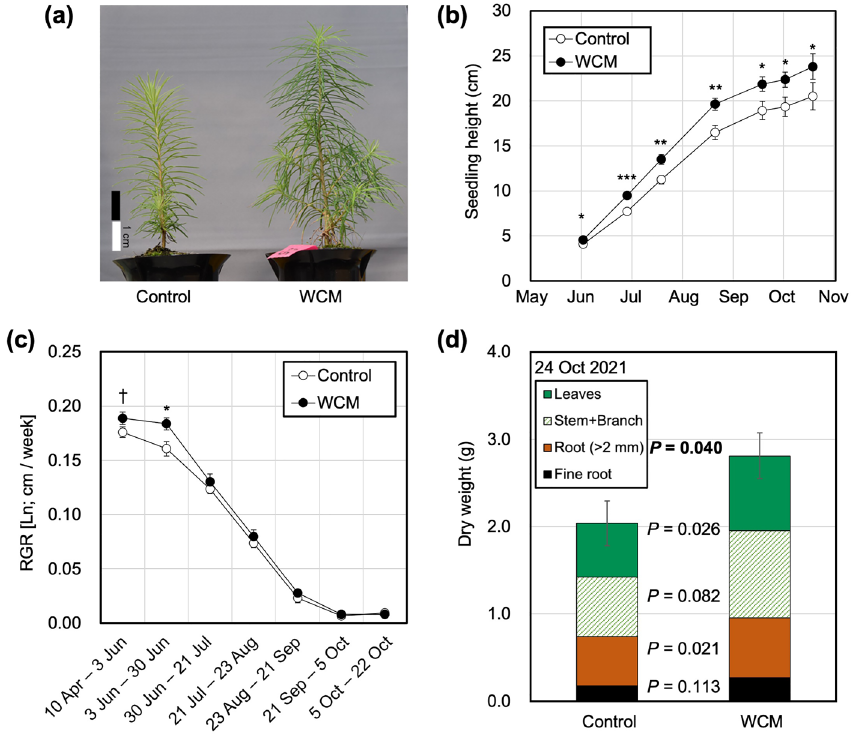
Figure 3. Growth of Japanese larch tree seedlings under UV-to-red WCM film. ( a ) Photograph of 4-month- old Japanese larch seedling grown under UV-to-red WCM film and non-treated film (control). ( b ) Seasonal change of seedling height. ( c ) Seasonal change of RGR. RGR was normalized by natural logarithm per week. Open and closed circles denote treatments of the control and WCM films, respectively. Error bars denote standard error. Statistical significance was examined in each month by Student’s t-test ( n = 81 and 70, † P < 0.1, * P < 0.05, ** P < 0.01, *** P < 0.001). ( d ) Dry weight of fine roots, thick roots, stem and branch, and leaves. Error bars denote standard error of total biomass. Statistical significance was examined for each organ and whole body by Student’s t-test ( n = 38 and